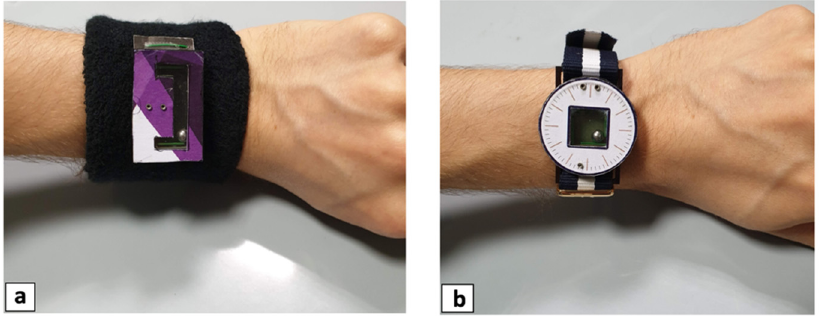
Figure 11. Images of the wearable mono-axial ( a ) and bi-axial ( b ) multi-converter harvester proto- types.